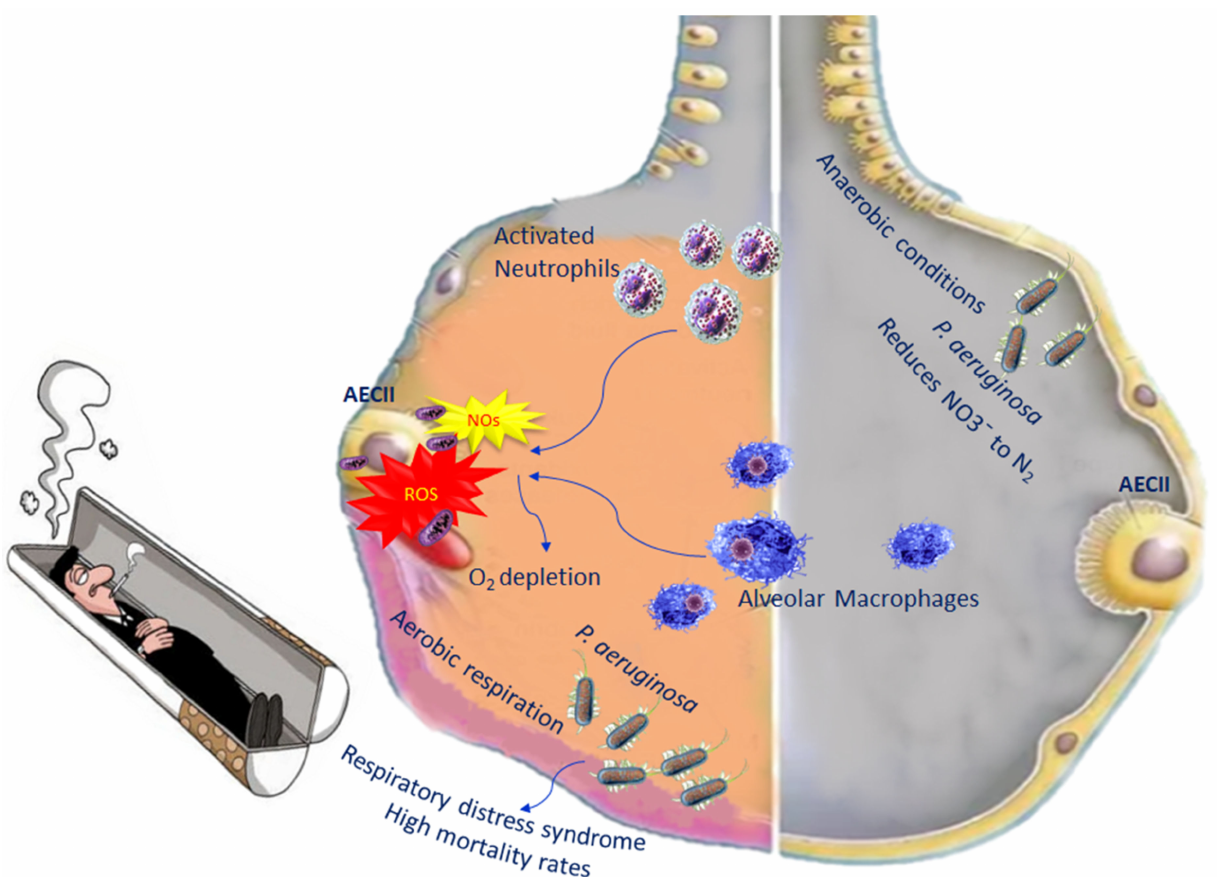
Figure 2. Impact of P. aeruginosa on oxidative stress in